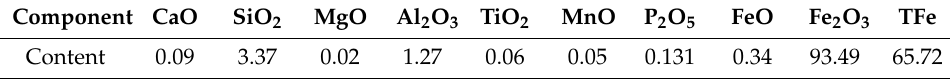
Table 1. Chemical composition of the hematite powder (wt.%).